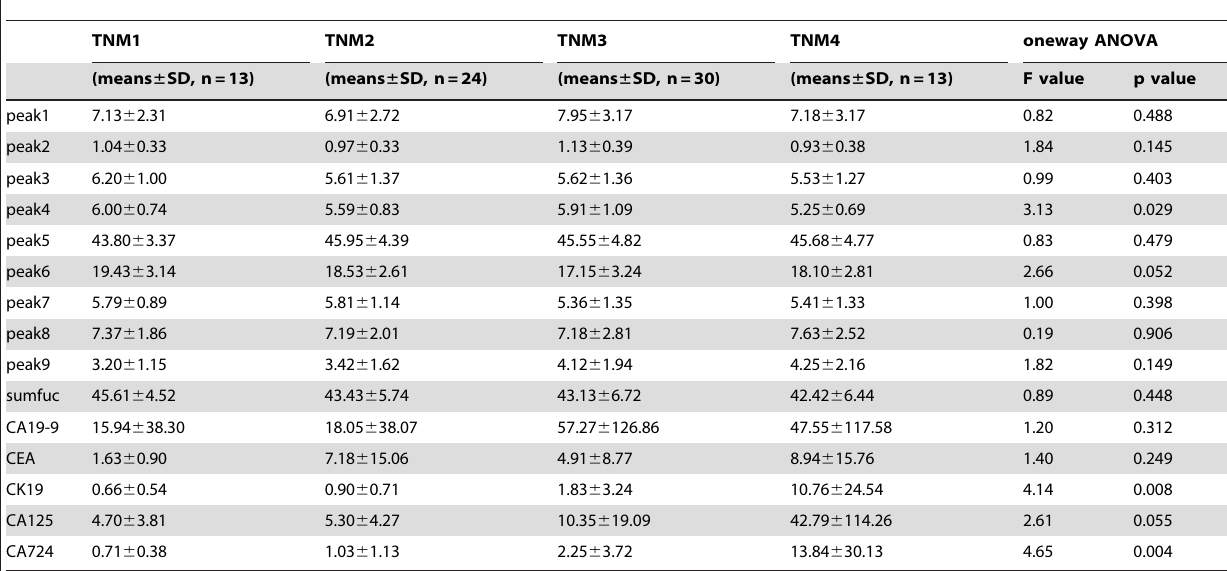
Table 3. N-glycome analysis in gastric cancer patients at different progression stages.